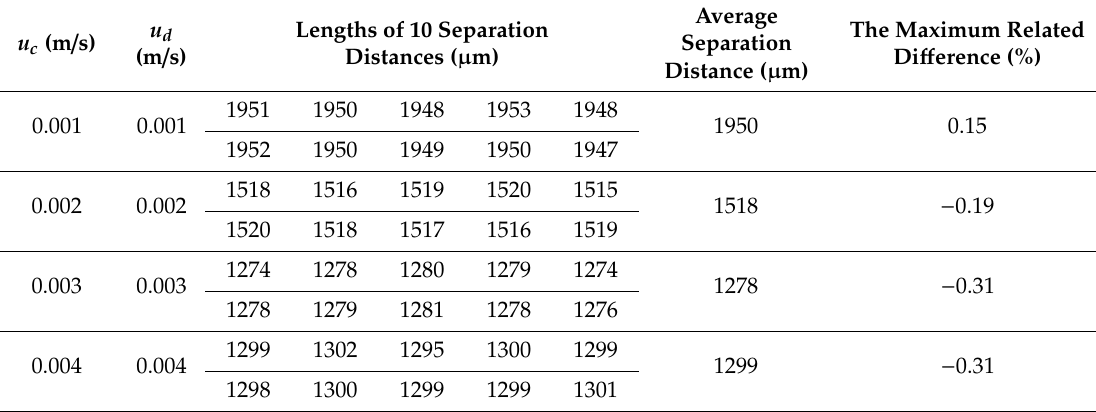
Table 3. The separation distance of experiments.